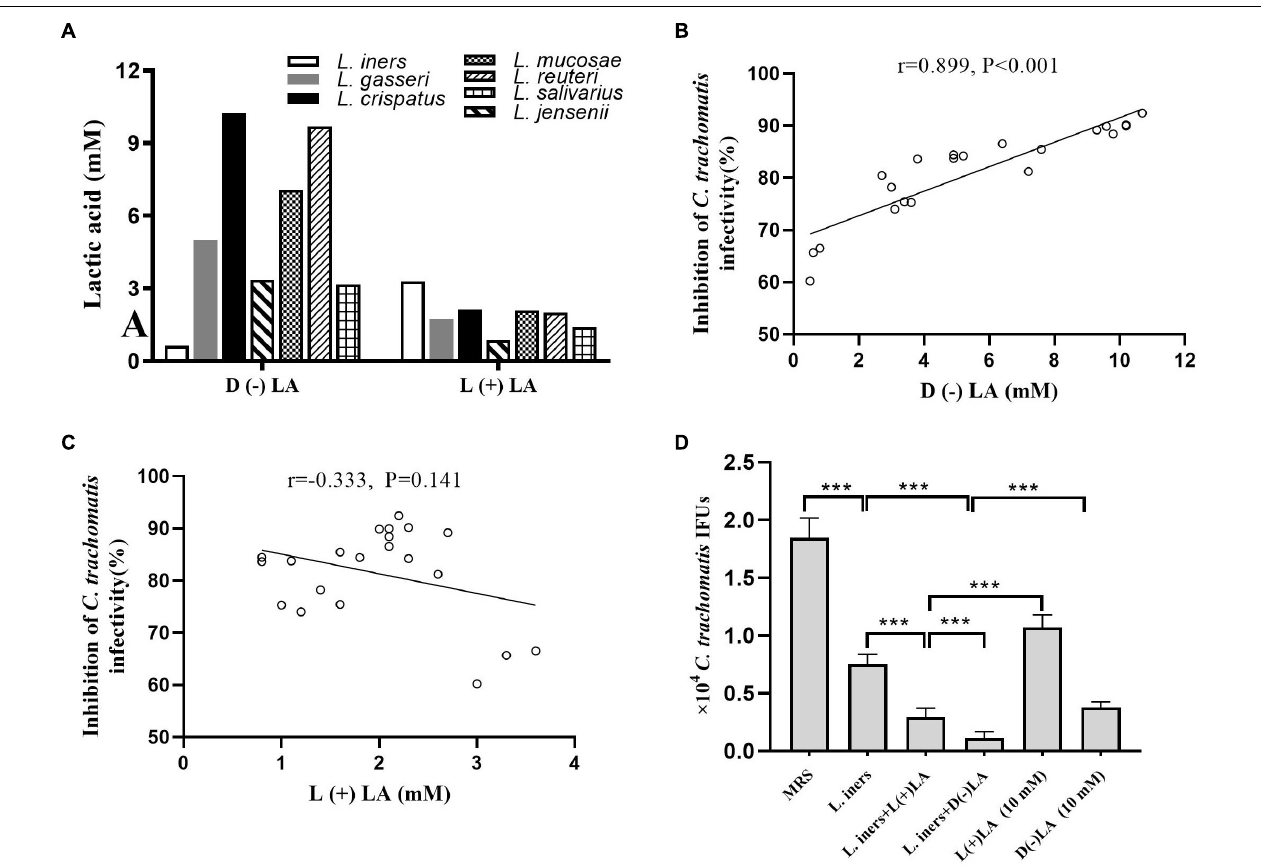
FIGURE 2 | Inhibition of C. trachomatis by lactobacillus-produced D ( − ) and L ( + ) lactic acid. (A) D ( − ) than L ( + ) lactic acid concentrations in overnight lactobacillus culture supernatants. Correlation between anti-chlamydial activity and concentration of D ( − ) (B) or L ( + ) lactic acid (C) . For Pearson correlation analysis, inhibition of C. trachomatis infectivity ( x axis ) was plotted against the concentration of D ( − ) lactic acid produced by each lactobacillus ( y axis). The correlation coefficient r between anti-chlamydial activity and D ( − ) lactic acid was 0.899, while r = 0.333 for L ( + ) lactic acid. (D) C. trachomatis EBs were pre-incubated with either an MRS bacterial culture medium (control), L. iners culture supernatants alone , L. iners culture supernatants supplemented with 9.3 mM D ( − ) or 6.7 mM L ( + ) lactic acid up to 10 mM, 10 mM D ( − ) or L ( + ) lactic acid alone. Each bar represents the mean ± SD of the IFUs from three independent experiments. Results of lactic acid isomers assays from an independent sample. *** p < 0.001 (one-way